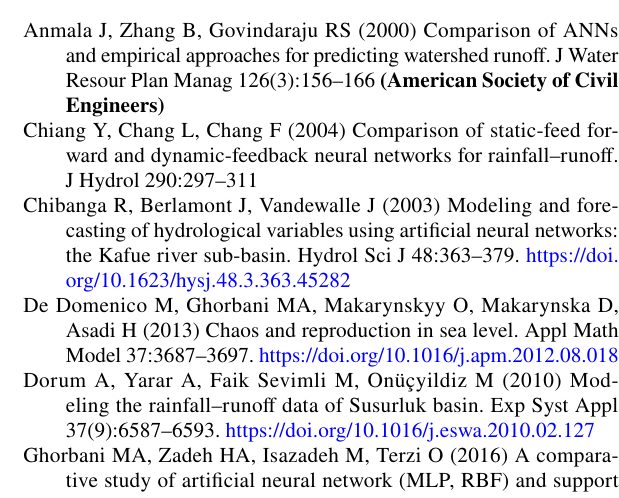
Fig. 6 Taylor diagram: performance measures for training and testing phases: a 3 data points of MLP, b 3 data points of